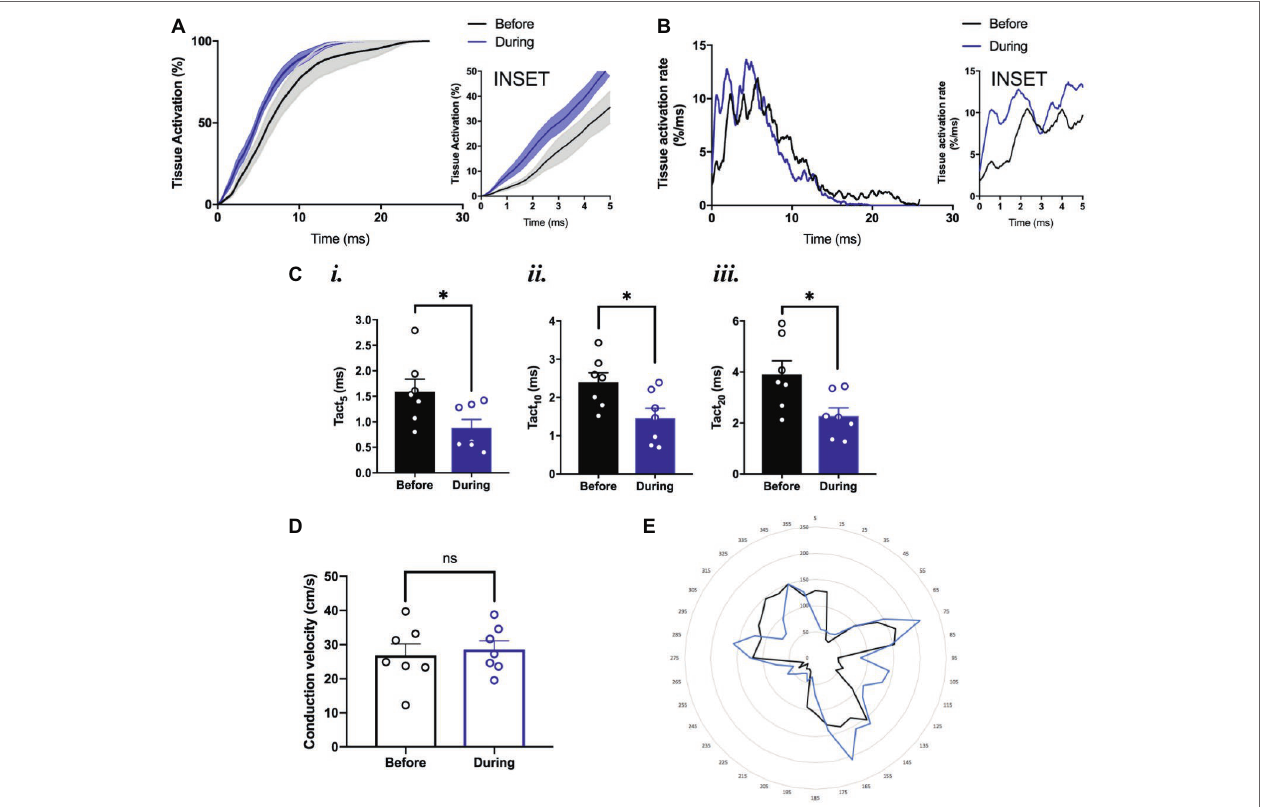
FIGURE 6 | Conduction pattern in the tissue under sinus rhythm and during optogenetic pacing. (A) Grouped activation curve showing mean % tissue activated over the time elapsed during a Ca 2+ transient. SEM denoted by shading. Inset: zoomed section of first 5 ms. (B) Rate of change of % tissue activation plotted against time. Inset as above. (C) ( i ) Time to 5% tissue activation. ( ii ) Time to 10% tissue activation. ( iii ) Time to 20% tissue activation. (D) Mean magnitude of local conduction vectors. (A–D) n = 7 throughout. (E) Representative radar plot, showing local conduction vector directionalities. Angles binned into groups of 10 °